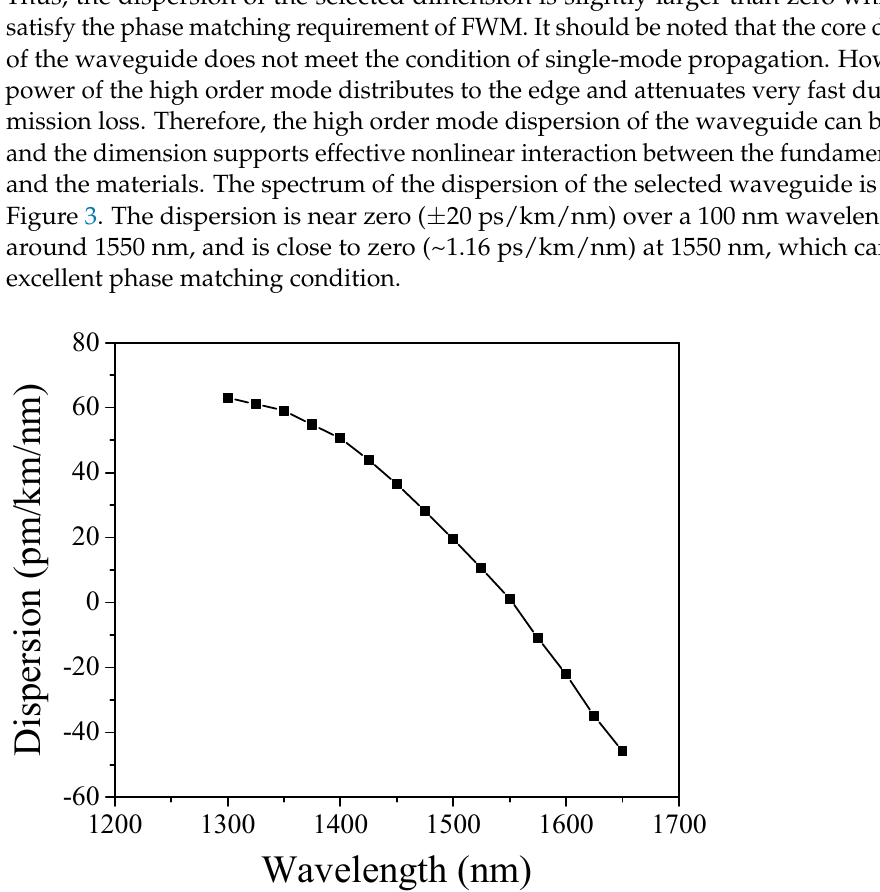
Figure 2. ( a ) The effective refractive index, and ( b ) the dispersion of PECVD silicon nitride wave- guide with different widths and thicknesses.